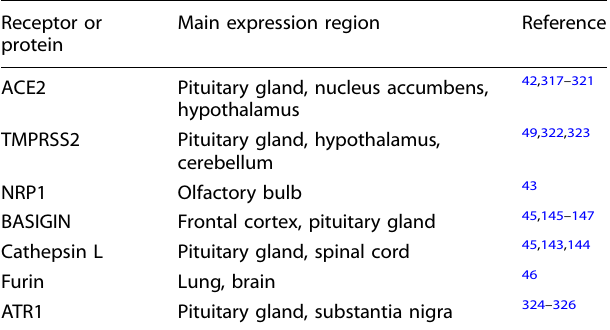
Table 2. Receptors or proteins related to SARS-CoV-2 infection in